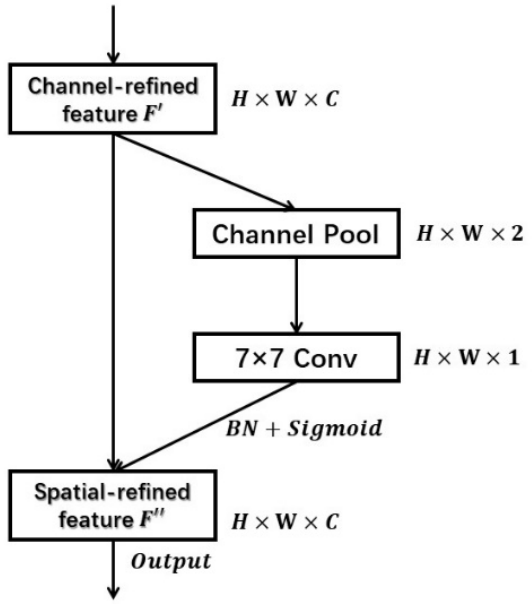
Figure 5. The structure of LRCA-Net’s spatial attention module.